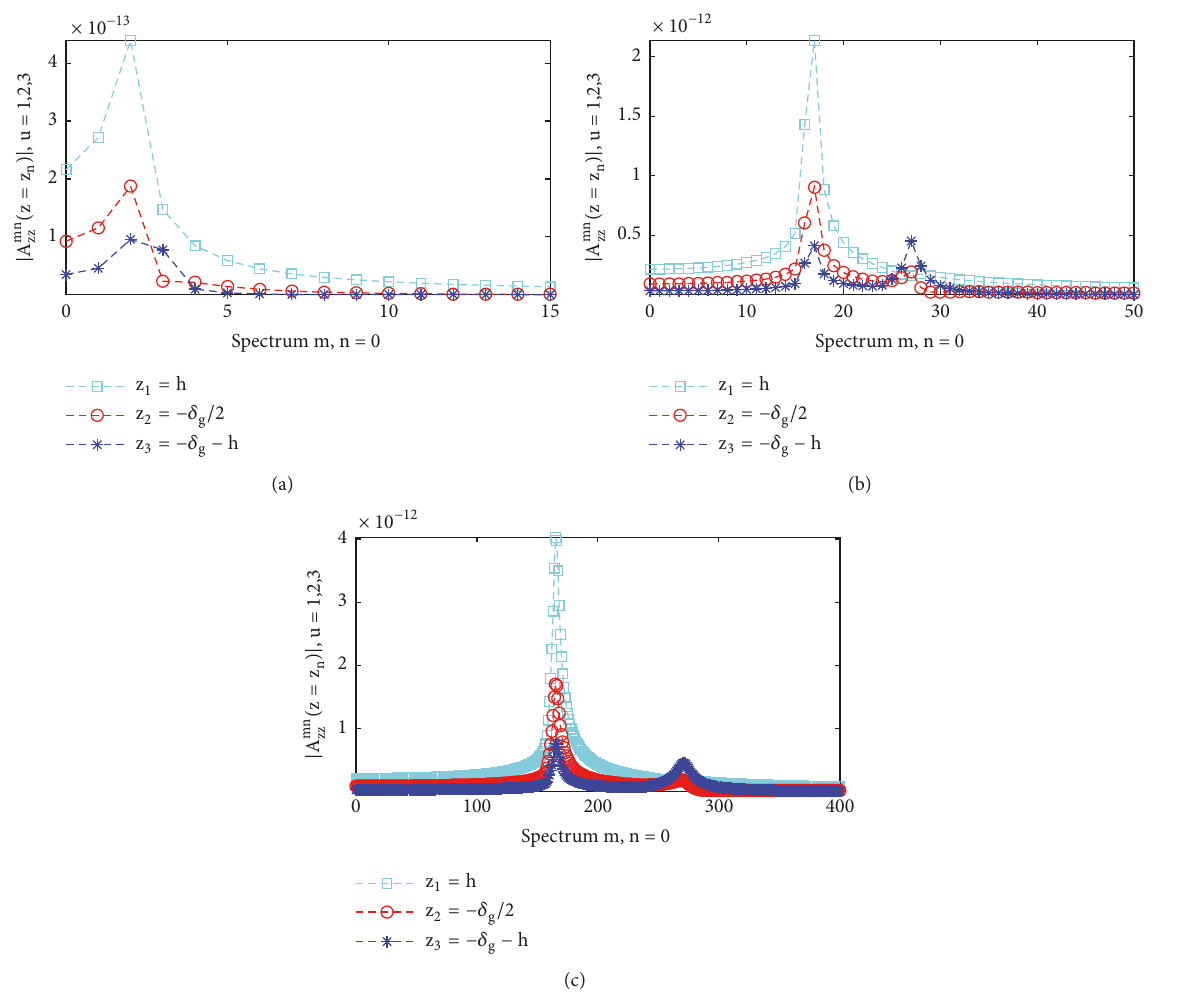
Figure 14: Spectral Coefficient 𝐴 𝑚𝑛 𝑧𝑧 (𝑧) at 𝑧 = 𝑧 𝑢 , with 𝑢 = 1,2, 3 and 𝑛 = 0 , for (a) Δ 𝑐 = 1𝜇𝑚 ; (b) Δ 𝑐 = 10𝜇𝑚 ; (c) Δ 𝑐 = 100𝜇𝑚 . In these results we set the following: 𝛿 𝑔 = 50𝑛𝑚 , ℎ = 20𝑛𝑚 , 𝜃 󸀠 = 𝜙 󸀠 = 0 ∘ , and 𝜆 = 632.8𝑛𝑚